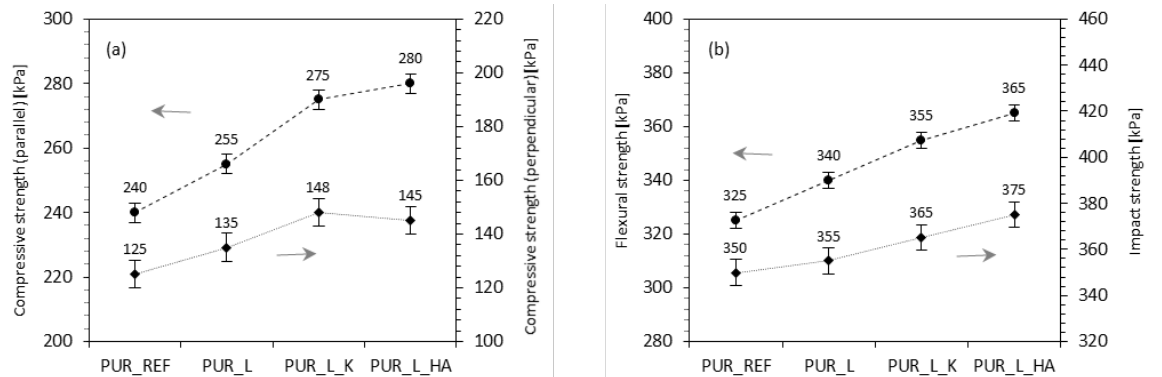
Figure 4. The mechanical performances of PUR foams: ( a ) compressive strength, ( b ) flexural strength, and impact strength. Adapted from Ref. [13].